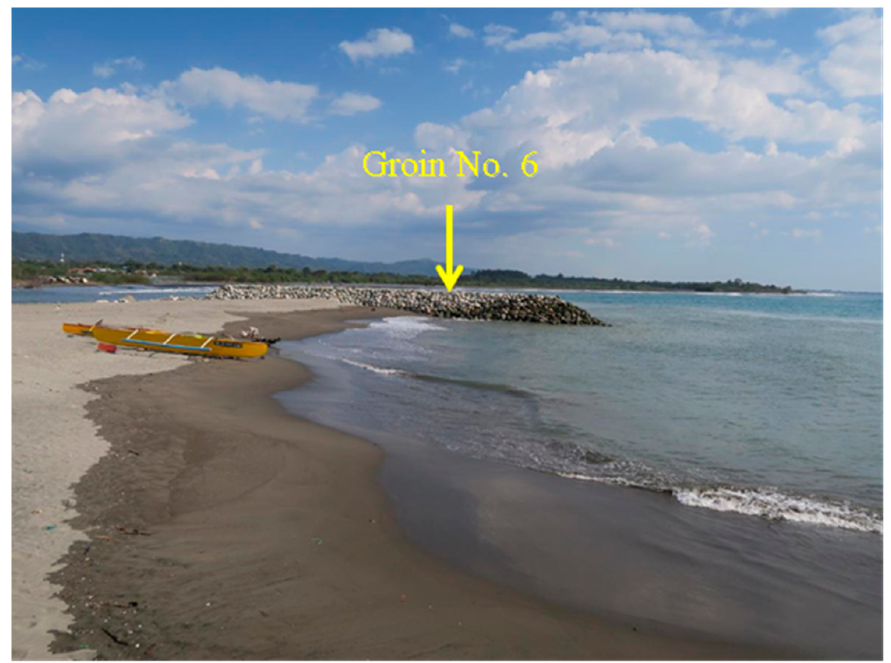
Figure 20. View of groin No. 6 taken from groin No. 5.